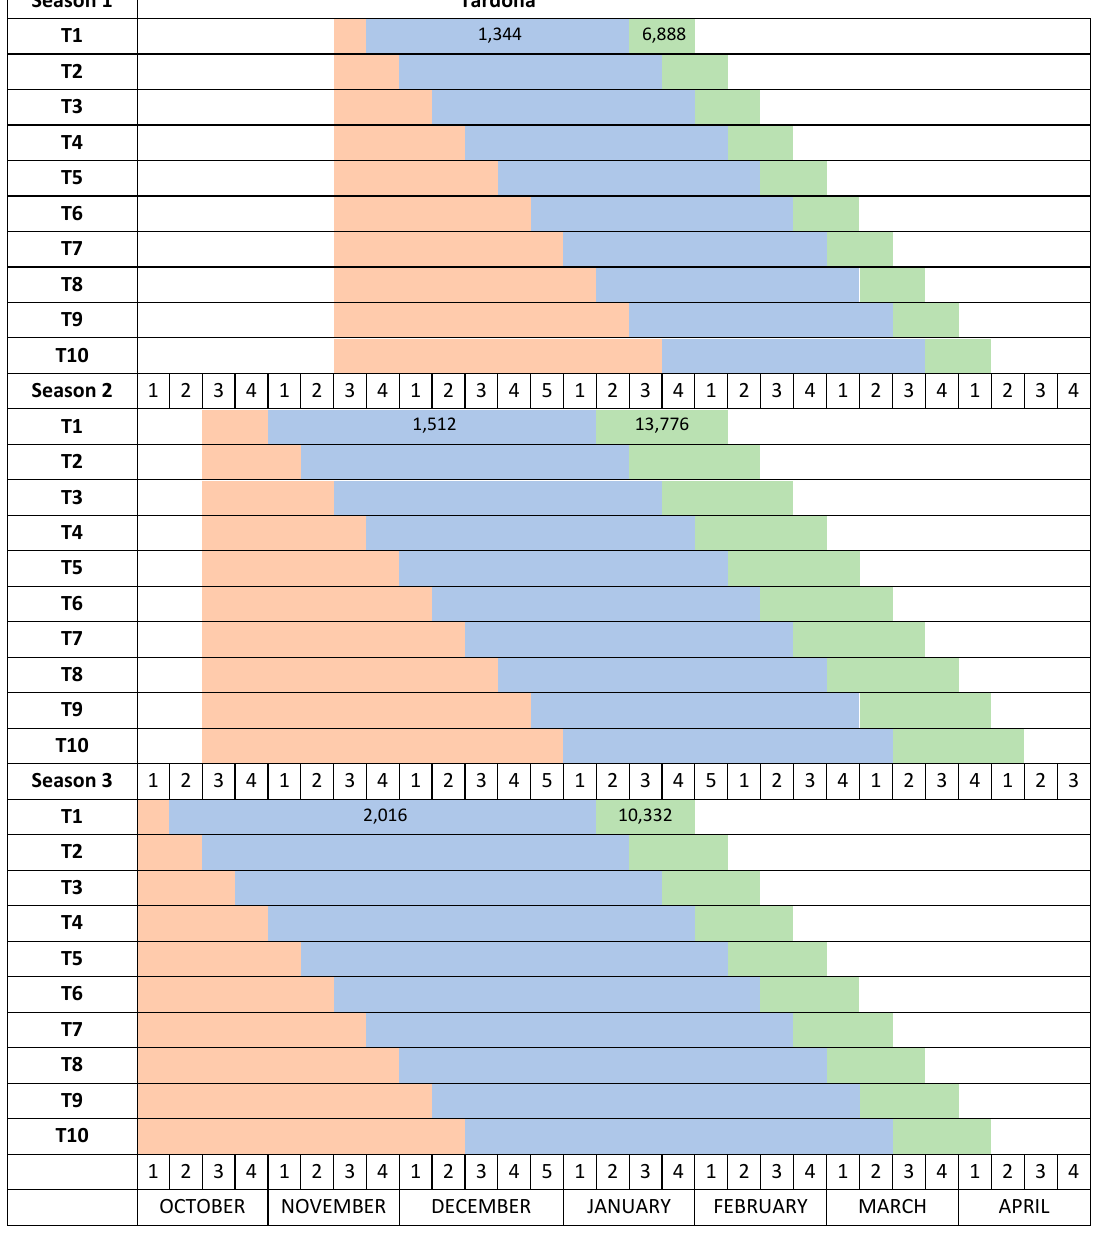
Figure 2. Experimental design of the temperature treatments (T1–T10) in the three controlled chambers during the three seasons studied. Autumn chamber (brown bars); Winter chamber (blue bars, with chill units accumulated); Spring chamber (green bars with growing degree hours (GDH) programmed). Months and weeks (1–5) along the treatment are indicated.